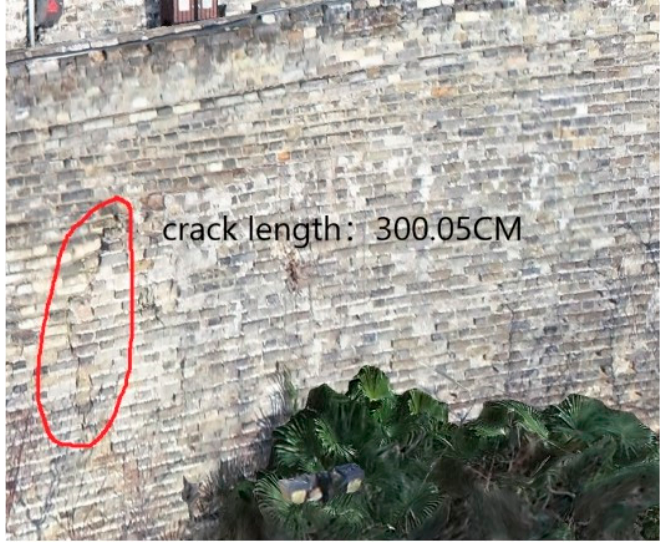
Figure 17. The longest crack in inner wall.